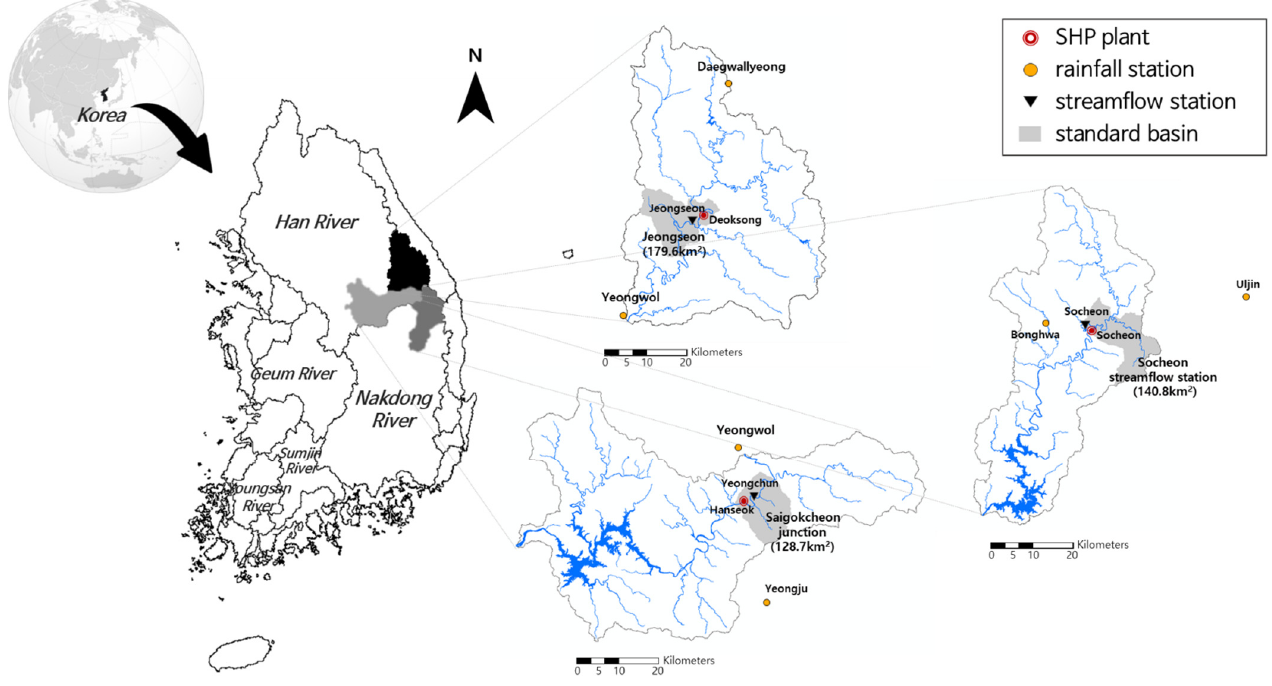
Figure 2. The study basins, basin area, locations of SHP plants, rainfall, and streamflow stations (reprinted from [8]).